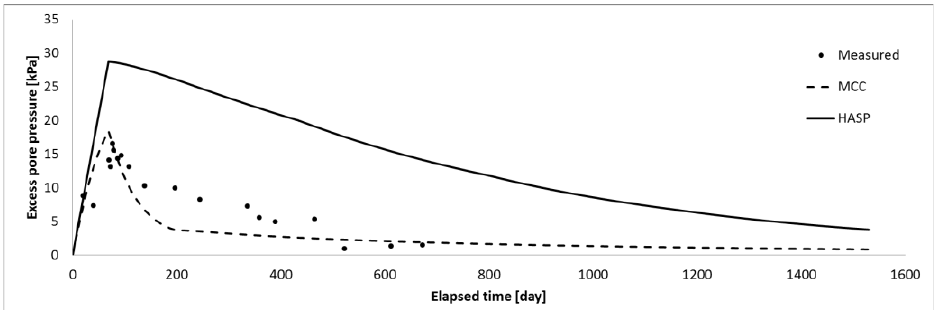
Figure 18. Comparison of excess pore pressure-time curves for Embankment B—Point PC2-2 (5.0 m below the surface).